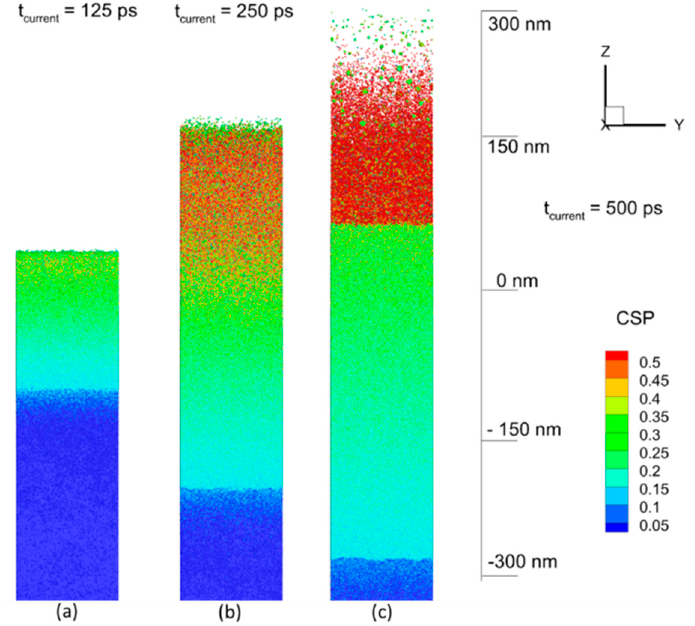
Figure 8. The result of 50 ps laser pulse interaction with Al in water at the working wavelength of 1064 nm and the incident fluence of 10 J / cm 2 is shown as the sequence of atomic snapshots for 125 ps ( a ), 250 ps ( b ), and 500 ps ( c ). The atoms are colored by central symmetry parameter (CSP) for identification of local atomic structure: Solid < 0.08 < defects < 0.12 < liquid < 0.25 < surface < 0.50 < vapor. The water atoms are blanked in all snapshots for a better visualization of the ablation process.